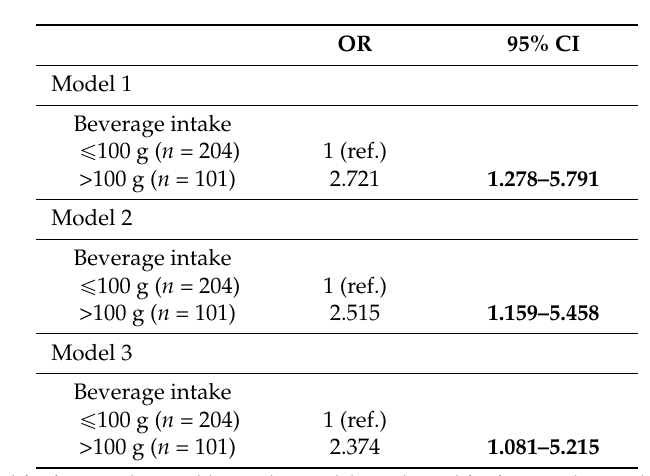
Table 6. Odds ratio (OR) and 95% confidence interval (CI) of urinary BPA levels ě 90th